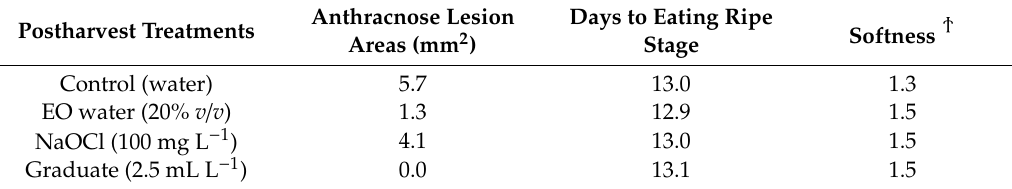
n = 4 replicates of 5 fruit per replicate.